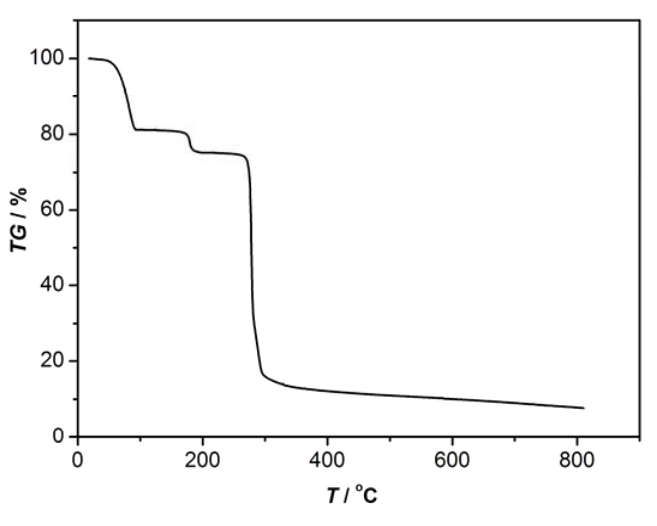
Figure 7. The TG-DTG curve of complex